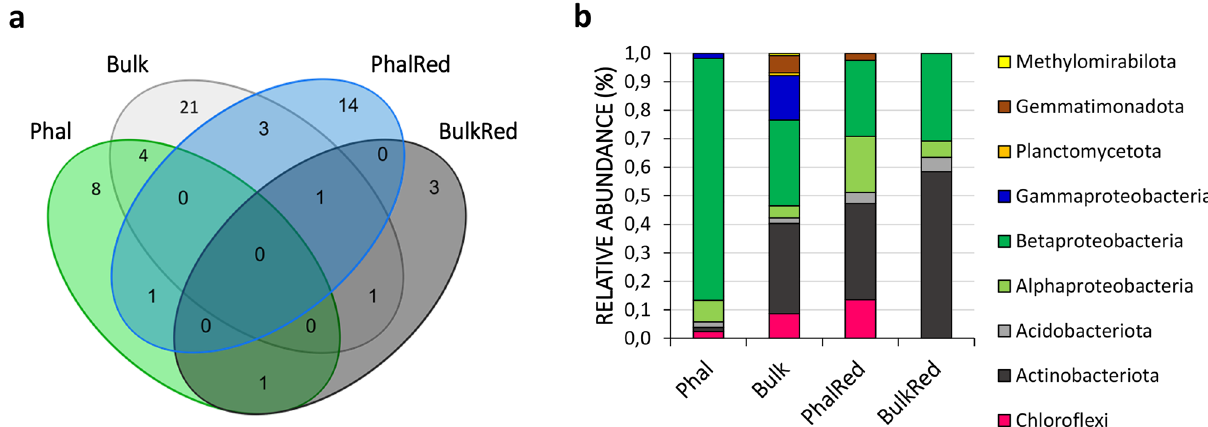
Figure 3. Distribution of ASVs and taxonomic diversity of bacterial populations incorporating 13 C from labeled 4-chlorobiphenyl associated to the different soils after twenty-eight days of SIP incubation. ( a ) Venn diagrams showing the shared and exclusive bacterial ASVs of the soils from the four different rhizoremediation treatments (Phal, Bulk, PhalRed, BulkRed). ( b ) Relative abundance of different bacterial phylum/class incorporating 13 C in the labeled D 28